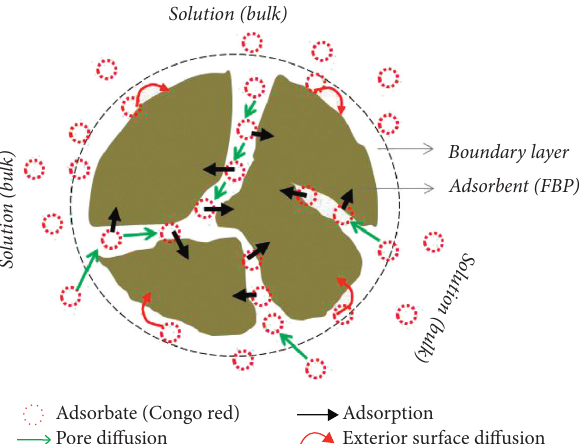
Figure 7: Schematic diagram of Congo red transport and sorption mechanism.